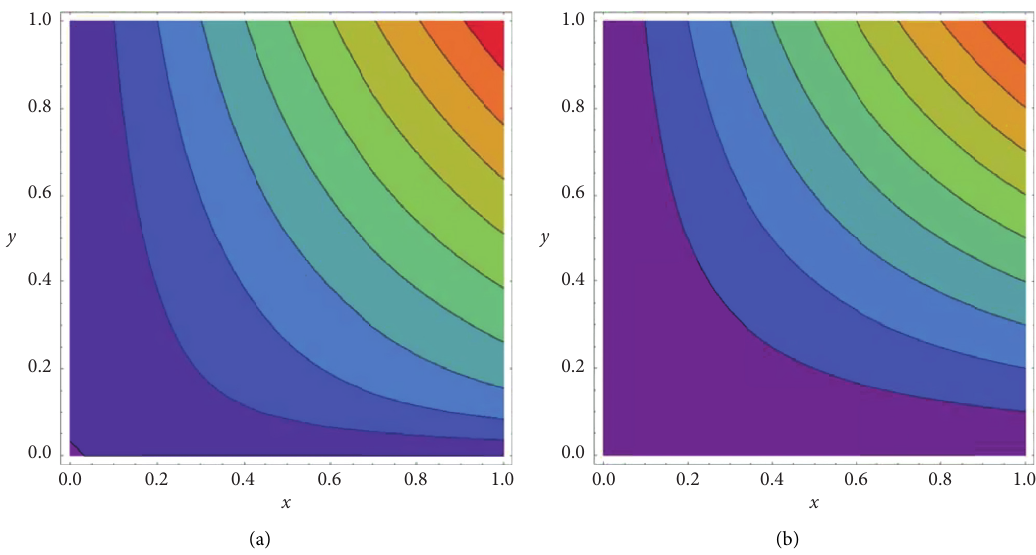
Figure 10: (a) Stream lines for c � 0.5. (b) Stream lines for c � 2.0.